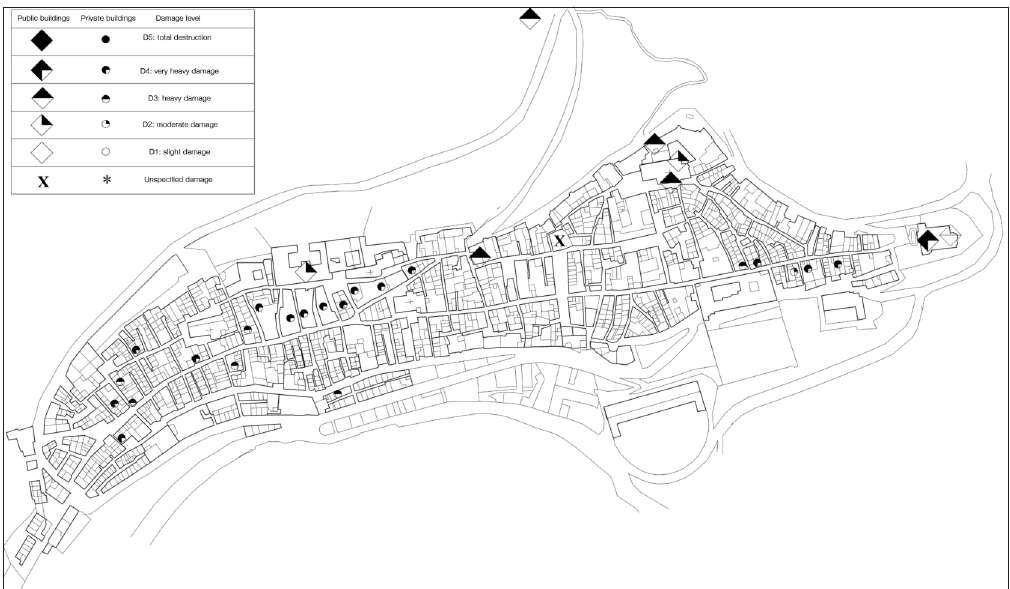
Fig. 3. 1826 damage ‘scenario’ for Potenza. The map highlights effects on the western flank of the hill and in the central-western area of the historical